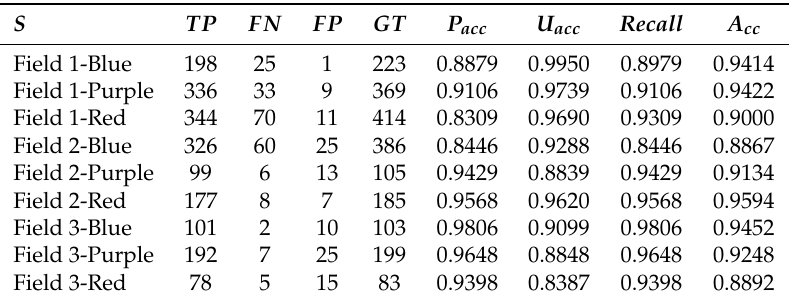
Table 2. Computed accuracy